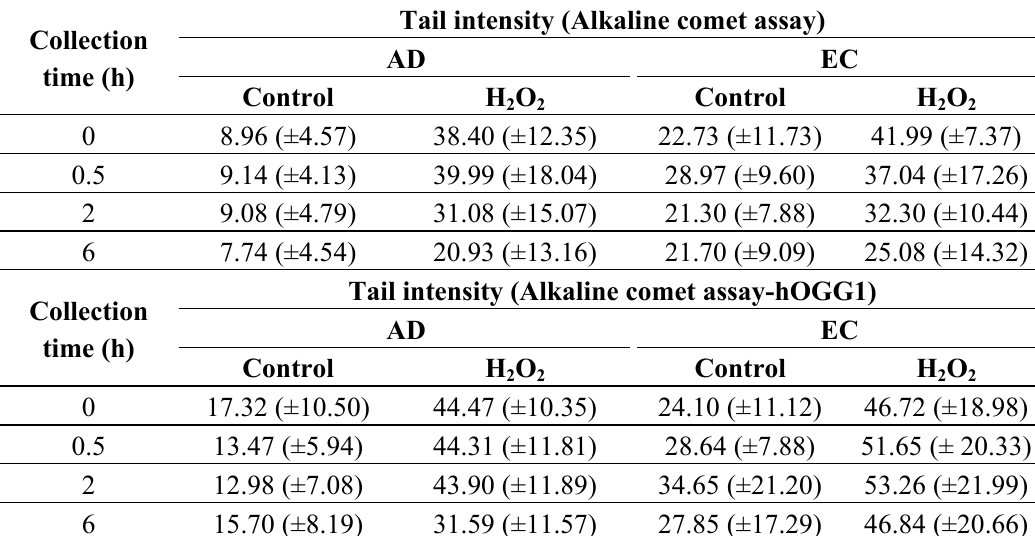
Table 1. Mean values (±standard deviation) of tail intensities obtained by the comet assay in lymphocytes of patients with Alzheimer’s disease (AD) and elderly healthy controls (EC); cells were cultured for 48 h, treated with H at different recovery times (0, 0.5, 2 and 6